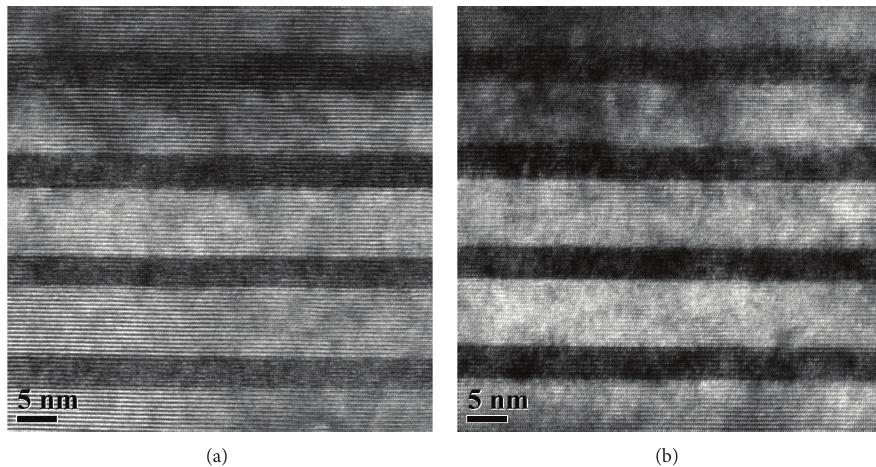
Figure 5: HR-TEM images of MQWs for two samples, (a) without TMIn treatment and (b) with TMIn